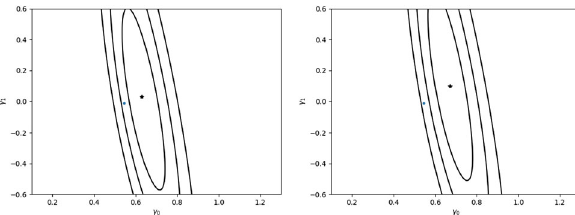
Fig. 3 Iso—likelihood contours for (cid:13)χ 2 = − 2ln L / L max equal to 2.30, 6.18 and 11.83, corresponding to 1 σ , 2 σ and 3 σ confidence levels in the (γ 0 ,γ 1 ) plane in the case of (cid:11) 1 parametrization. The bias model is that of SMT, while the star corresponds to the best-fit point and the dot to the theoretical (cid:7) CDM point (γ 0 ,γ 1 ) = ( 0 . 556 , − 0 . 011 ) . In the right panel we present the contours that obtained using the Planck TT + TE + EE + low + lensing (cid:7) CDM cosmology [2], while in the left the contours obtained using DES/Planck/JLA/BAO (cid:7) CDM cosmology χ 2 = 15 . 033 (AIC=19.533), while in the case of Planck min TT + TE + EE + low + lensing (cid:7) CDM cosmology we get = 0 . 670 ± 0 . 073, γ = 0 . 100 ± 0 . 422 with χ 2 γ 0 1 min